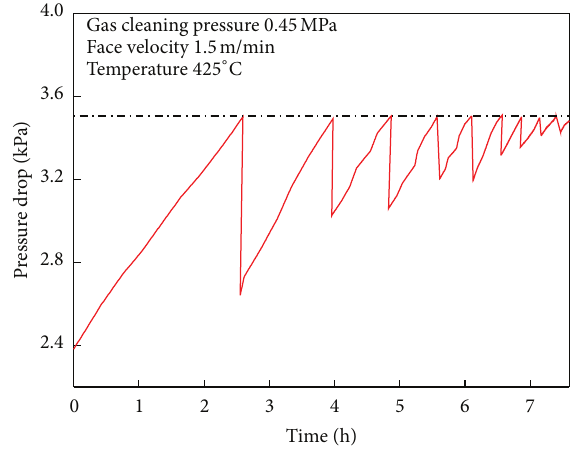
Figure 14: Pressure drop variations for gas cleaning pressure of 0.68 MPa, 0.6 MPa, and 0.53 MPa.